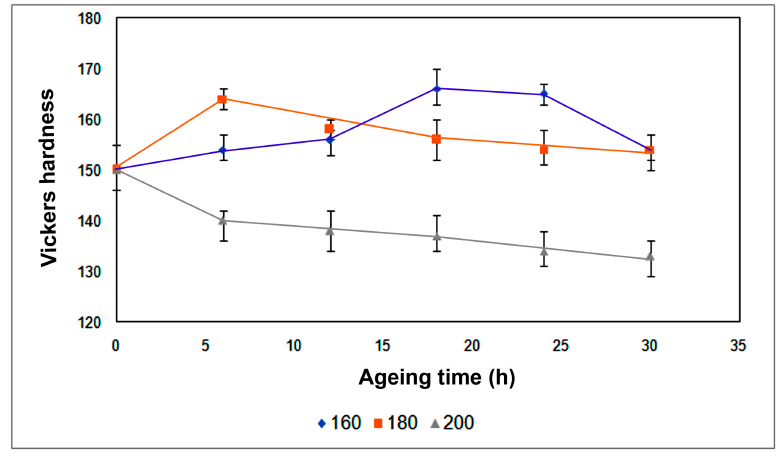
Figure 12. Hardness profiles of the specimens treated at 495 °C for 4 h and subsequently cold rolled until achieving a deformation of 25%, with ageing treatments at 160, 180, and 200 °C, respectively. Error bars define the distance between the maximum and minimum values vs. the average value.